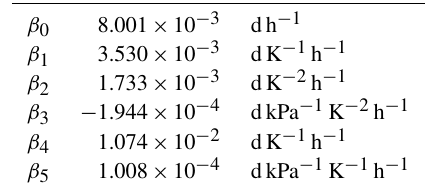
Table 1. Coefficient values for β in Eq. (4), adopted from Landman